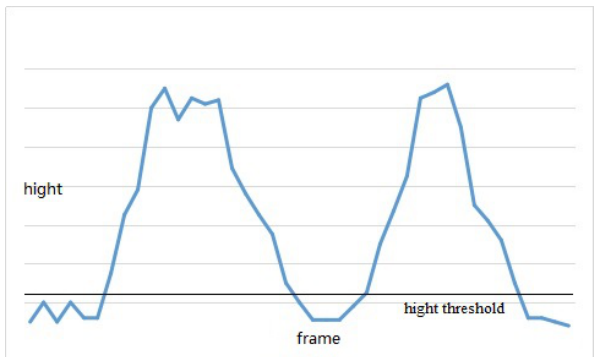
Figure 4. An example of the temporal segmentation result with hand positions for a continuous gesture